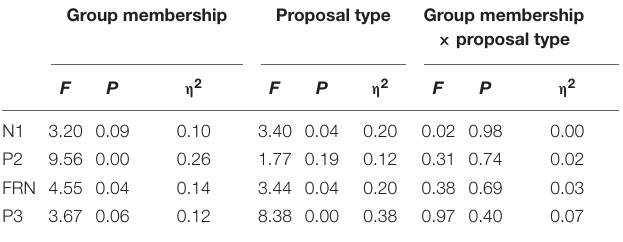
TABLE 2 | The ANOVA of the electroencephalogram (EEG) data in different group